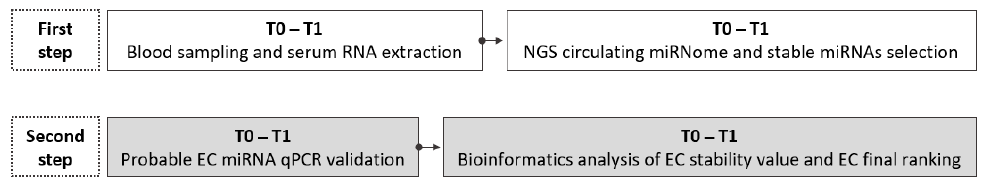
Figure 1. Research flowchart. In the first step, in a sample size of six dogs, a subset of miRNAs is identified by NGS as stable miRNAs. The white box shows all the phases performed in the first step: blood sampling at T0 and T1, serum RNA extraction, NGS circulating miRNA profiling, and stable miRNA selection. In the second step (gray boxes), the phases are stable miRNA qPCR validation (22 dogs) and bioinformatics analysis of qPCR output data to determine EC miRNAs’ stability